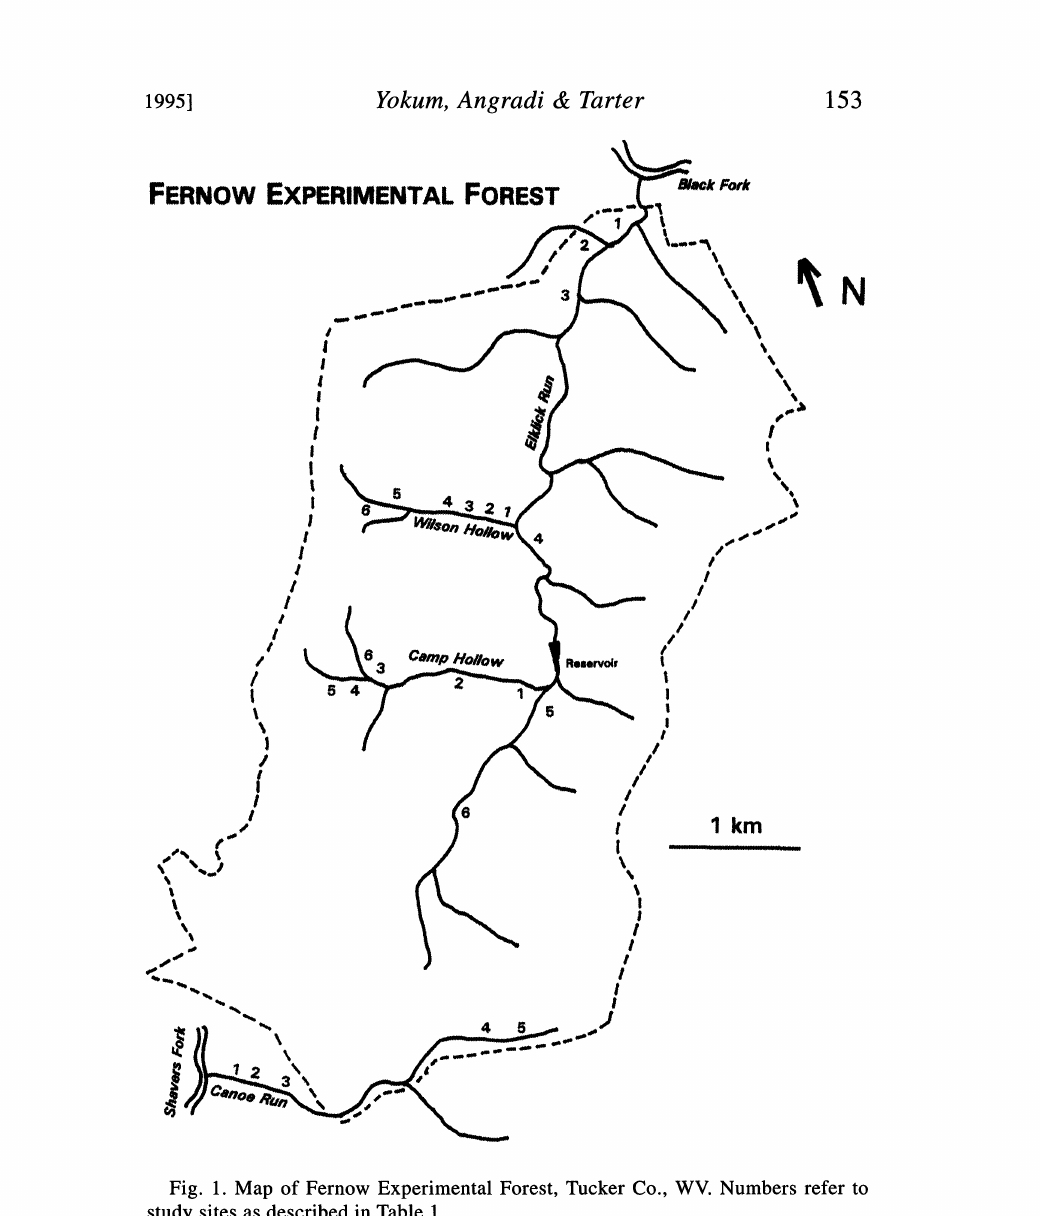
Fig. 1. Map of Fernow Experimental Forest, Tucker Co., WV. Numbers refer to study sites as described in Table